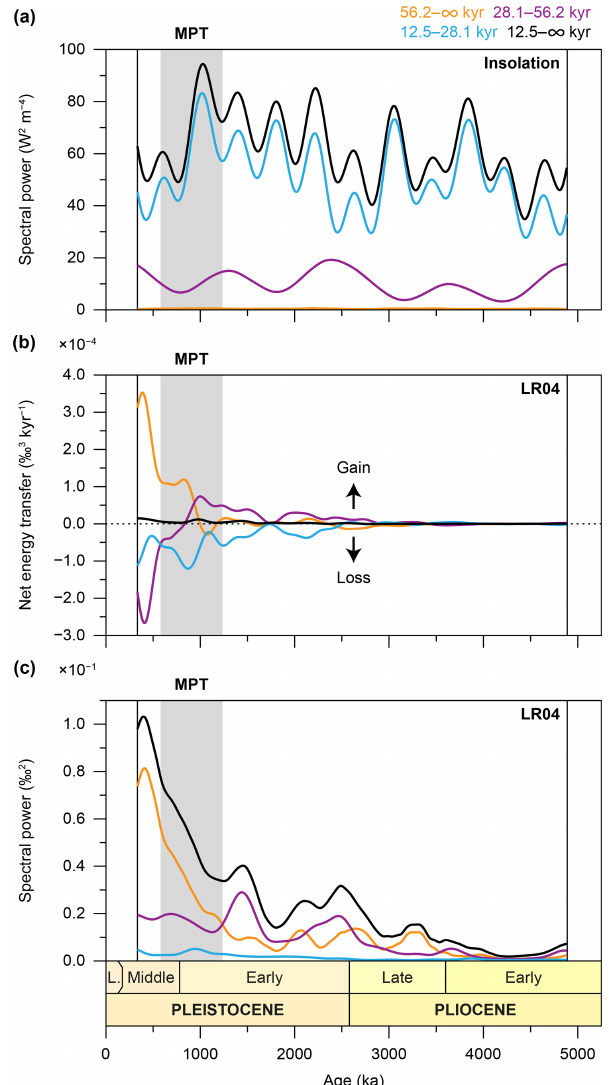
Figure 7. Integration of the spectra and bispectra per astronomi- cal bandwidth (top right). (a) Totally and zonally integrated spectra of mean summer insolation (21 June to 21 September) at 65 ◦